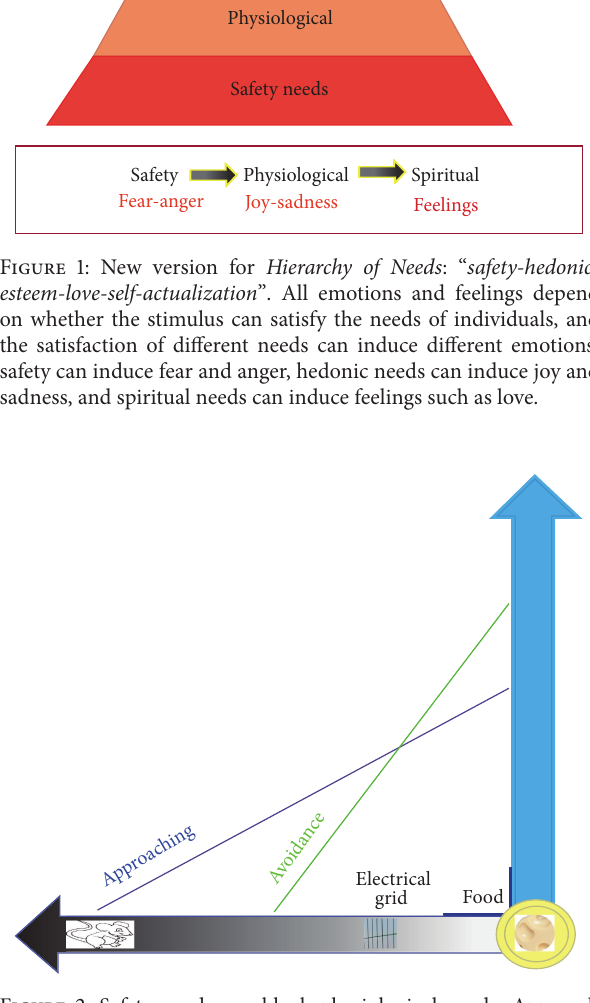
Figure 2: Safety needs can block physiological needs. Approach and avoidance gradients depend on the distance from the goal. Goalincludesthefood(physiologicalneeds),whilethepunishments include the foot shock (safety needs). The avoidance slope is steeper and predominates proximally to the goal, whereas the approach gradients are higher at the remote